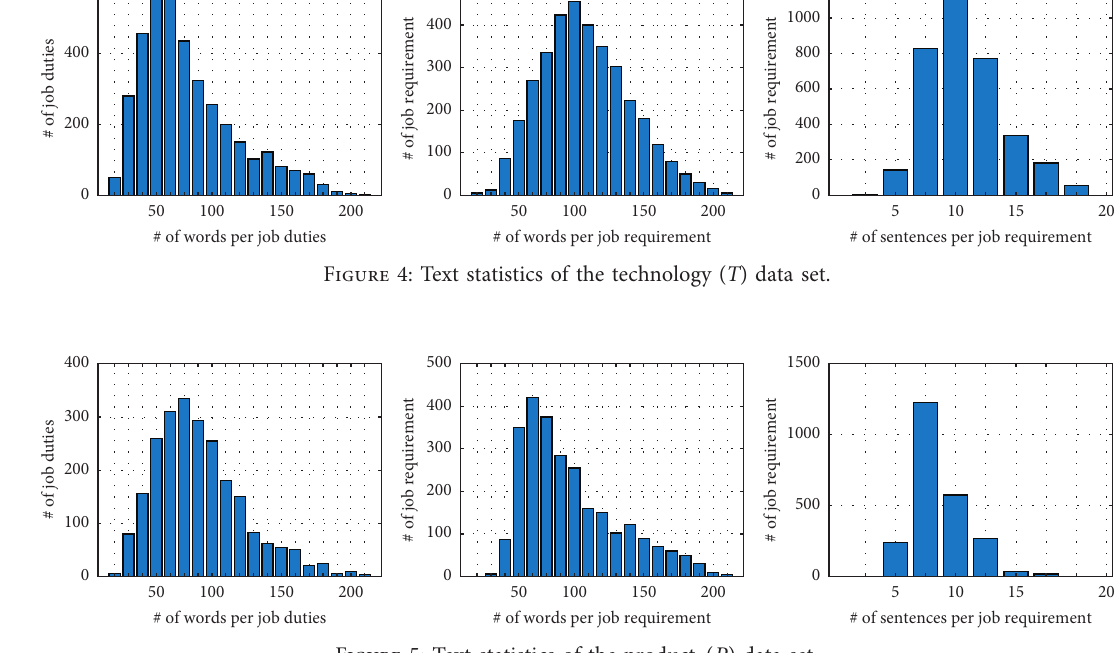
Figure 5: Text statistics of the product ( P ) data